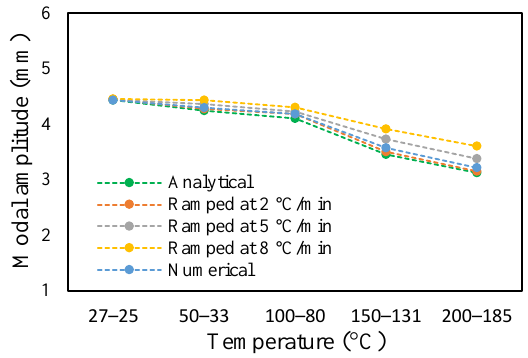
Figure 17. Modal amplitude of 0.5 mm crack depth in non-uniform temperature.